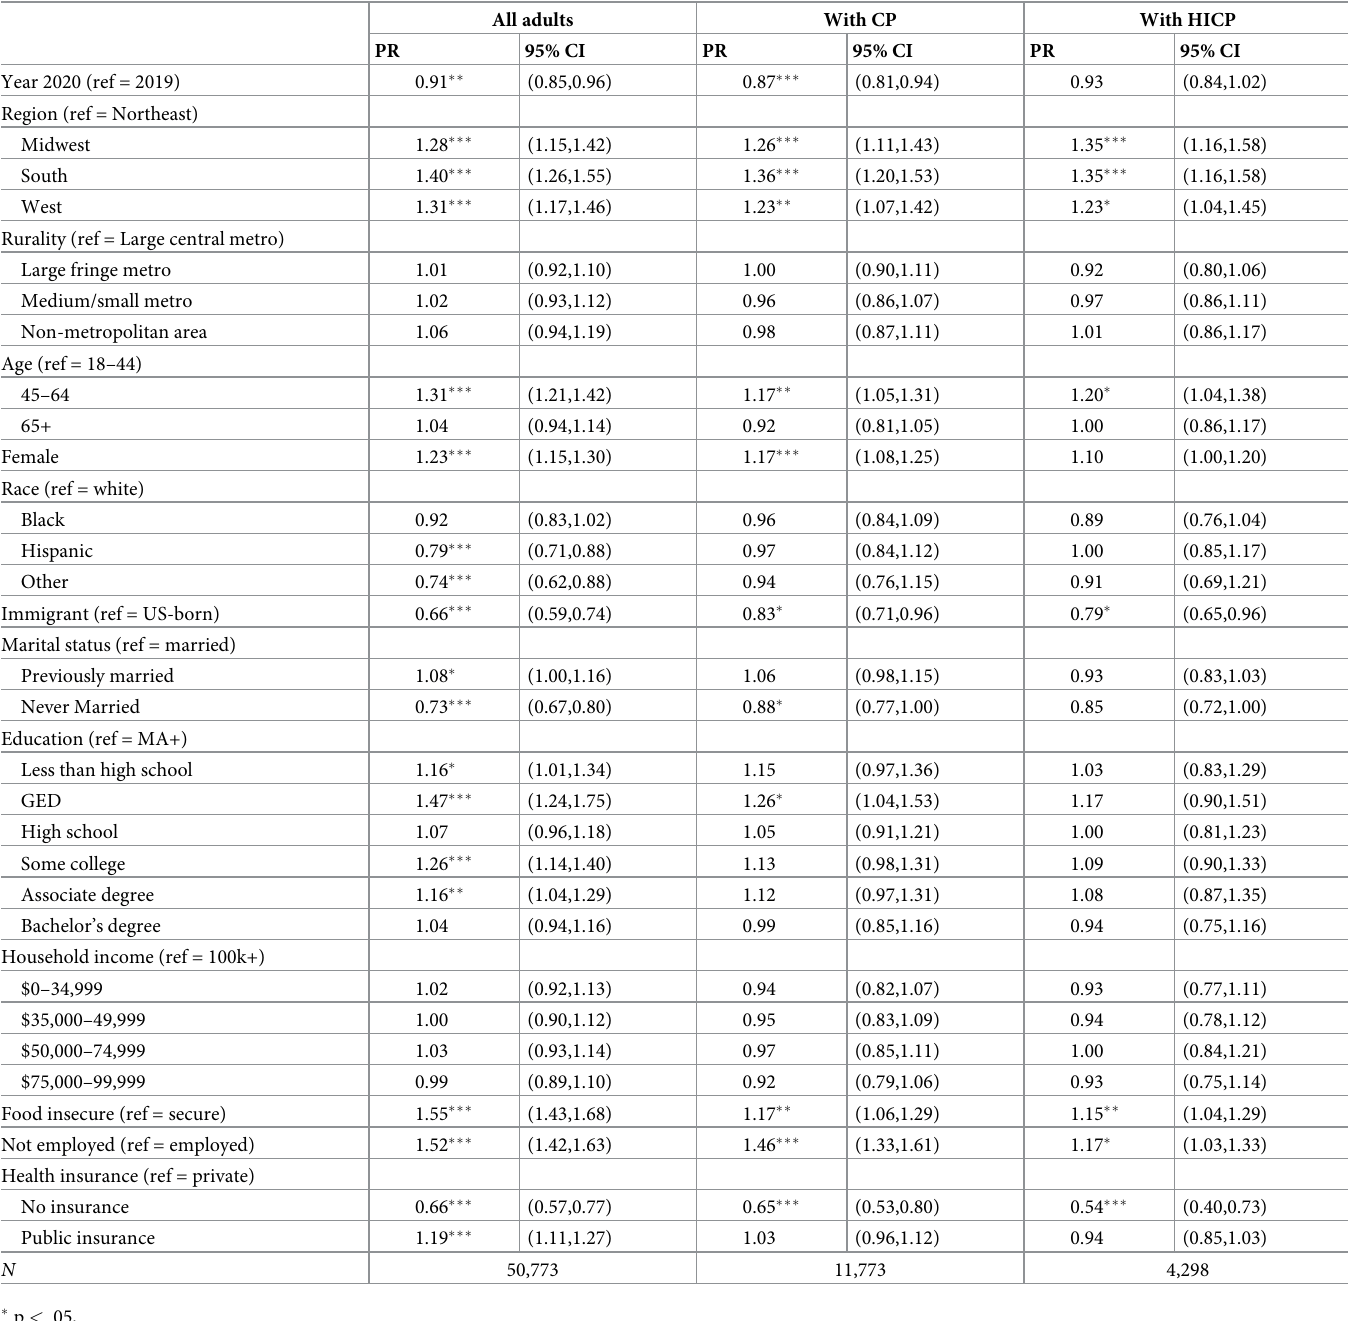
Table 2. Prevalence ratios for POU in fully-adjusted models, US adults 18+, NHIS 2019–2020.